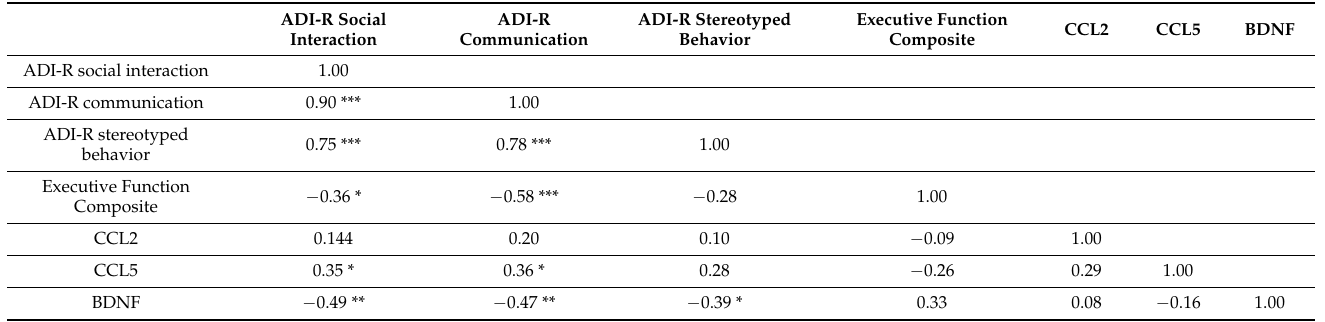
Table 4. Pearson association analysis of the three subscales of ADI-R with executive function compos- ite, mean concentrations of CCL2, CCL5, and BDNF in all participants enrolled (n = 33 ˆ). ADI-R Social